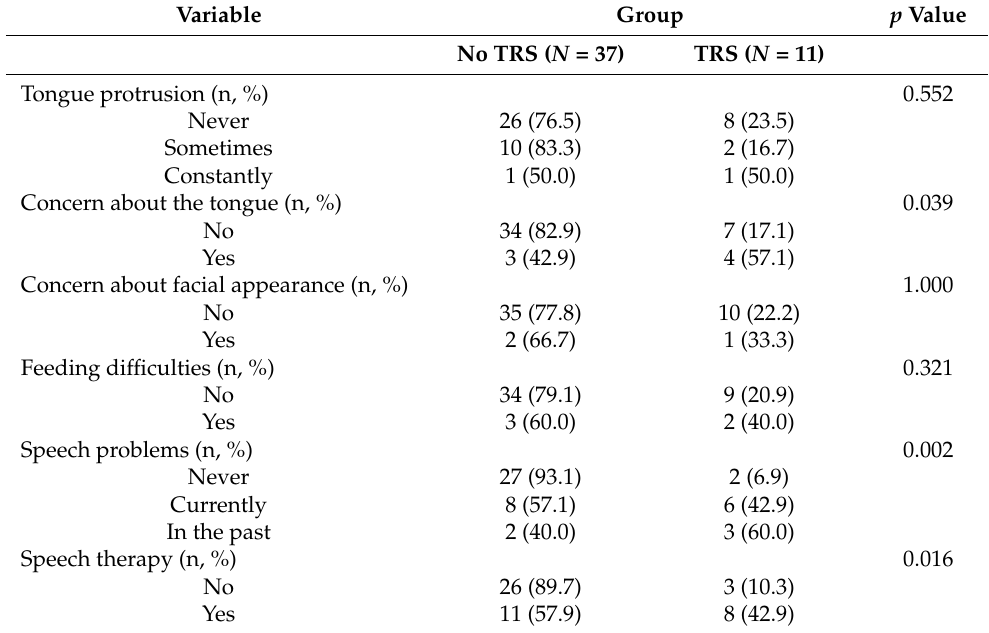
Table 6. Aesthetic, feeding and speech problems after tongue reduction surgery